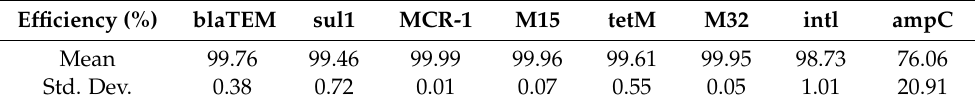
Table 2. Estimated ARGs removal efficiency during wastewater treatment in WWTP Brno Modˇrice. Figure 7. Relative abundance obtained from qPCR Ct values (normalized ARGs copies to 16s rRNA copies) of the seven ARGs analyzed in the surface water taken upstream and downstream of the WWTP analyzed in the surface water taken upstream and downstream of the WWTP. ● indicate data points located outside whiskers of the Tukey's boxplot (outliers)